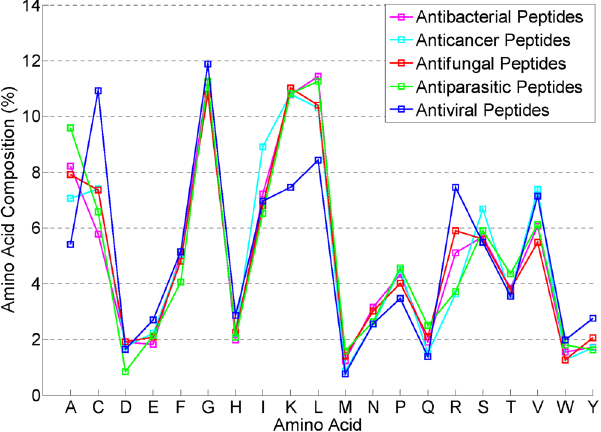
Figure 2. Averaged amino acid composition of AMPs with different activities in the filtered